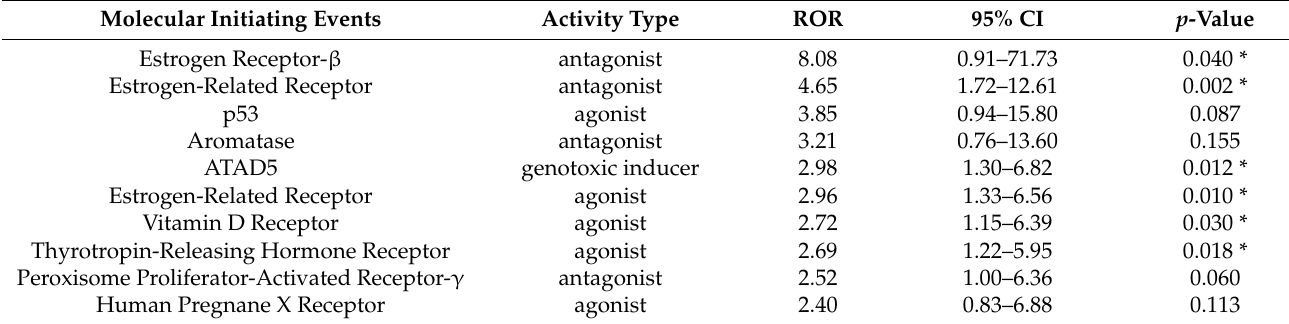
Table 6. Molecular initiating events (MIEs) related to liver malignant tumor-inducing drugs.